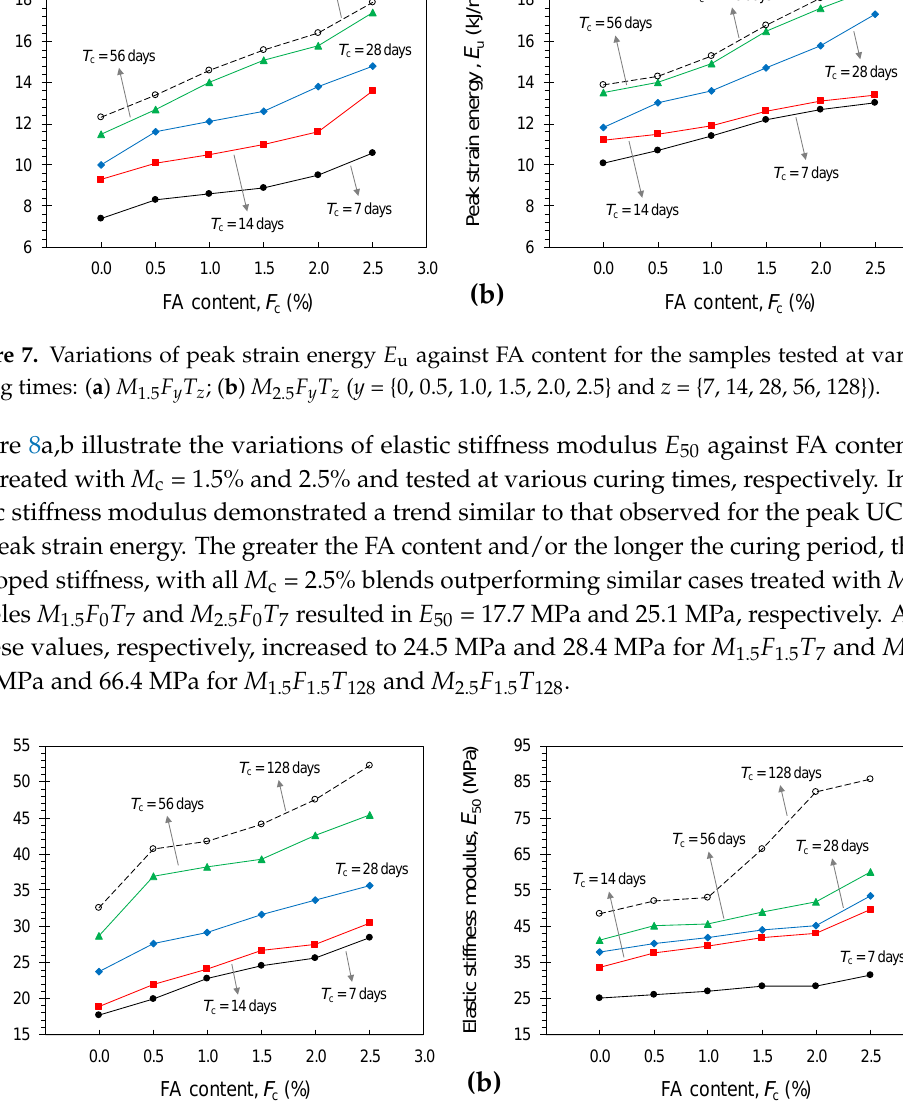
Figure 6. Variations of axial strain at failure ε u against FA content for the samples tested at various curing times: ( a ) M 1.5 F y T z ; ( b ) M 2.5 F y T z ( y = {0, 0.5, 1.0, 1.5, 2.0, 2.5} and z = {7, 14, 28, 56, 128}).